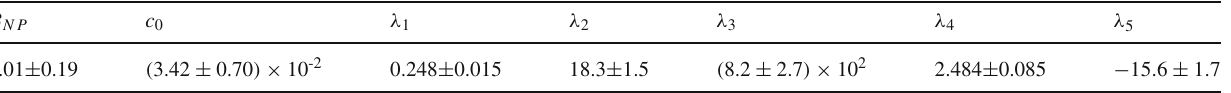
Table 6 Intervals for the TMD non-perturbative parameters calculated as explained in the